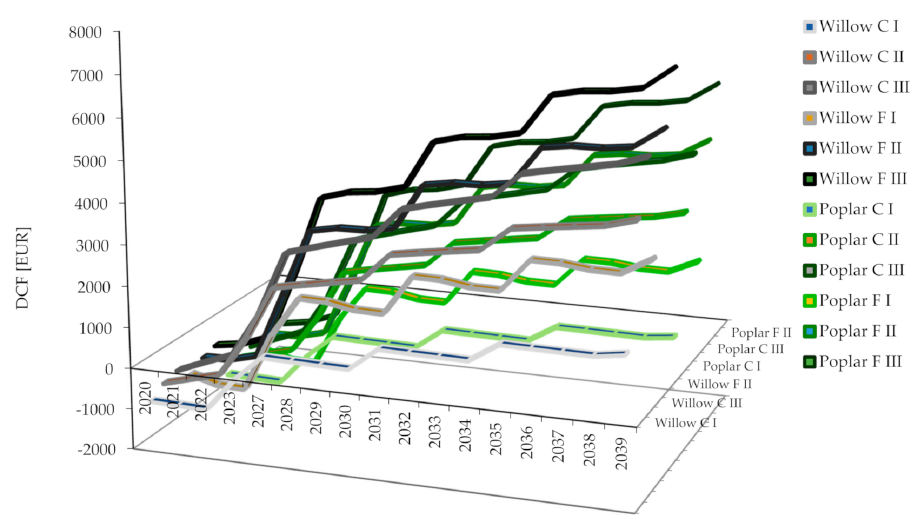
Figure 1. Discounted cash flows for willow and poplar chip production depending on the soil fertilisation option and subsidy scenario.